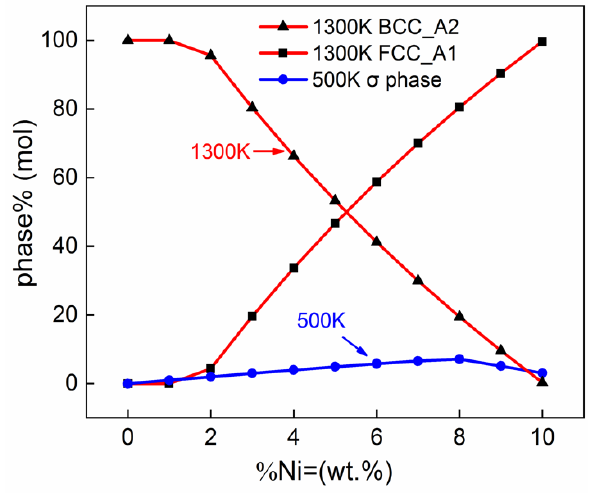
Figure5. RelationshipbetweenNicontentinalloyand σ Figure 5. Relationship between Ni content in alloy and σ phase volume content in Fe-8 wt.%Cr-4 wt.% Al.